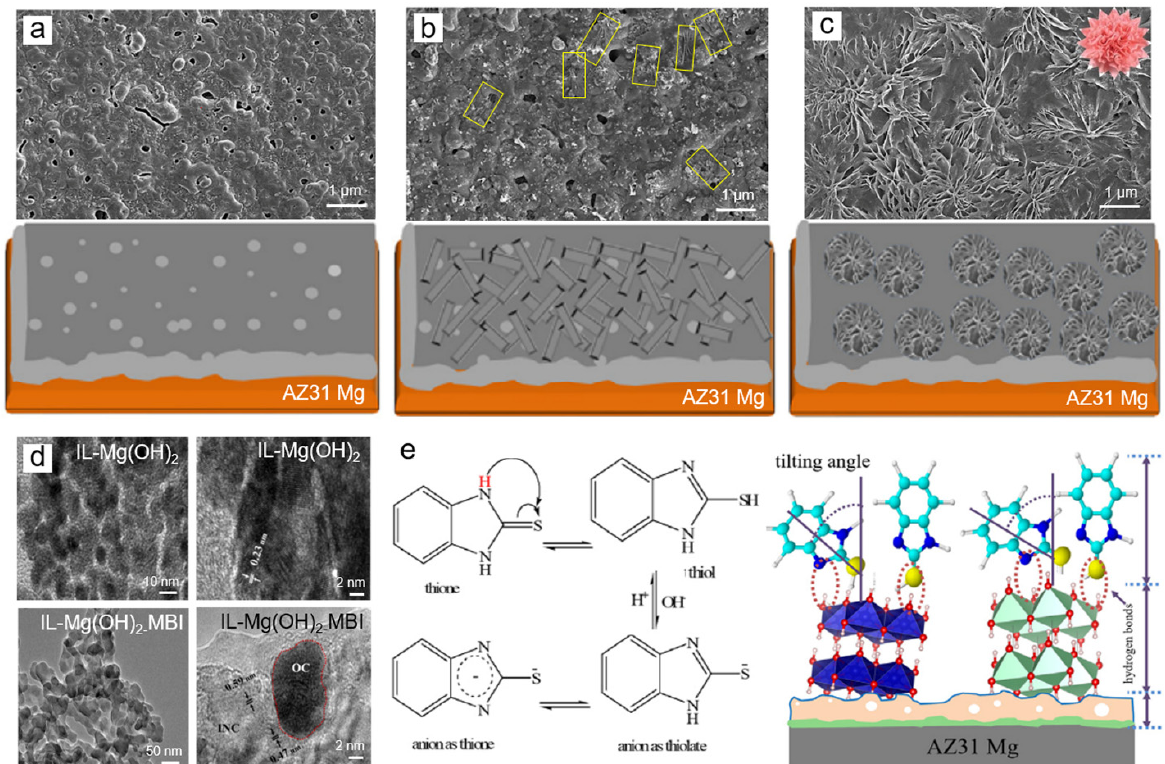
Figure 4. Structural changes in the surface of IL ( a ) fabricated on AZ31 Mg alloy by PE followed by first DCC in FBA containing solution resulting in IL–FBAs and ( b ) second DCC in ethanolic solution containing MBI at ambient temperature for one day to obtain IL–FBAs-MBI ( c ) Representative TEM and HR-TEM of IL–Mg(OH)2 and IL–[Co(OH)2)–Mg(OH)2]– MBI ( d ), and Schematic illustration showing adsorption mechanism of MBI molecules on functionalized IL ( e ). Adapted with permission from [24]. Copyright © 2020 Elsevier .